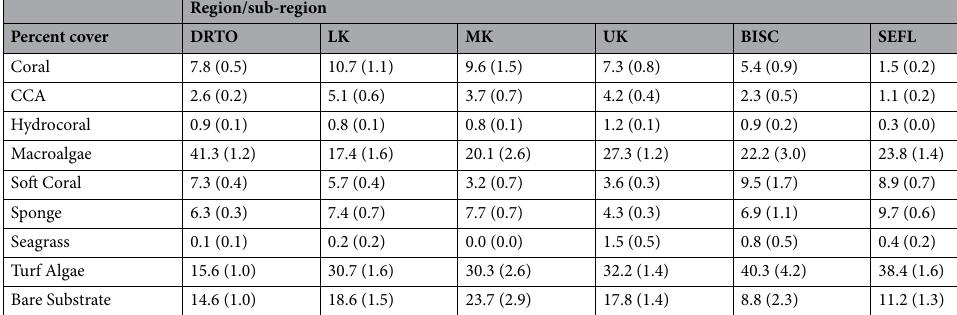
SEFL reefs had the lowest parrotfish density and second lowest parrotfish biomass measured along the FRT. Associated with this was the smallest percent contribution by parrotfish to gross carbonate erosion, with SEFL being the only region/sub-region to have virtually equal parrotfish and microbioerosion rates (Table S1). These reduced parrotfish populations appear to be uniquely driven by regional benthic cover, with SEFL reef systems